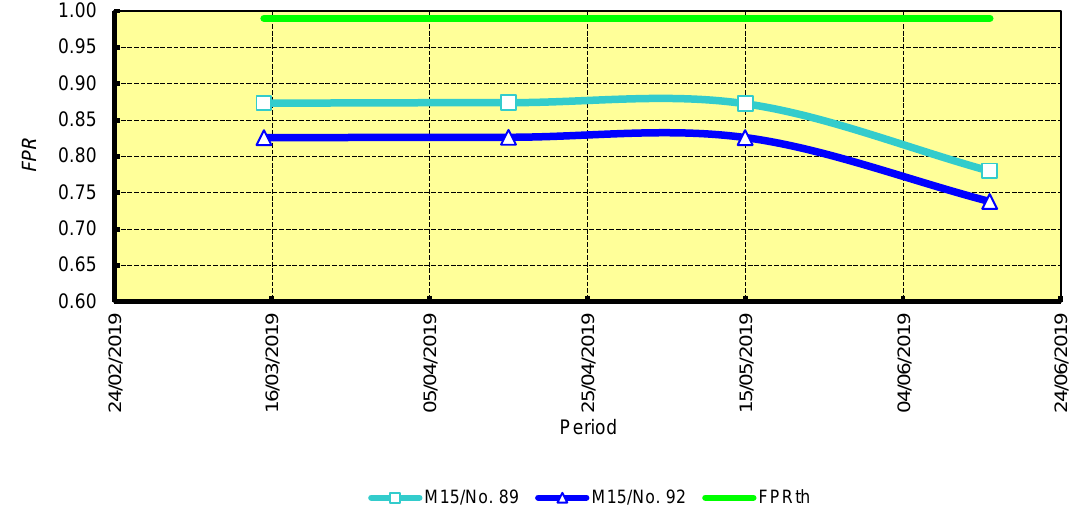
Figure 10. M15 / petrol prices ratio. Figure 10. M15/petrol prices ratio.